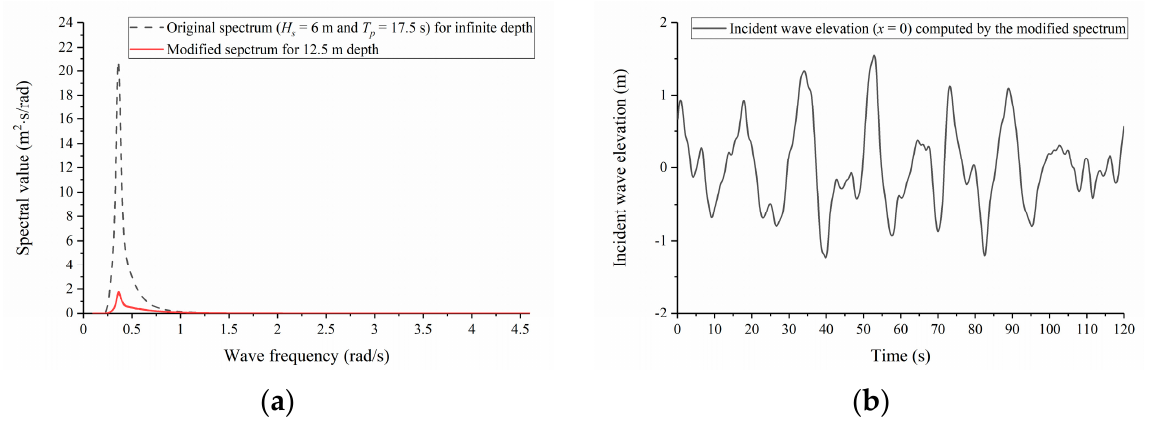
Figure 24. Irregular wave parameters: ( a ) comparison between original JONSWAP spectral values for H s = 6 m and T p = 17.5 s and its modified spectral values in 12.5 m-deep water; ( b ) time–history wave elevation of the modified irregular wave for a specific array of random phases of wave components.